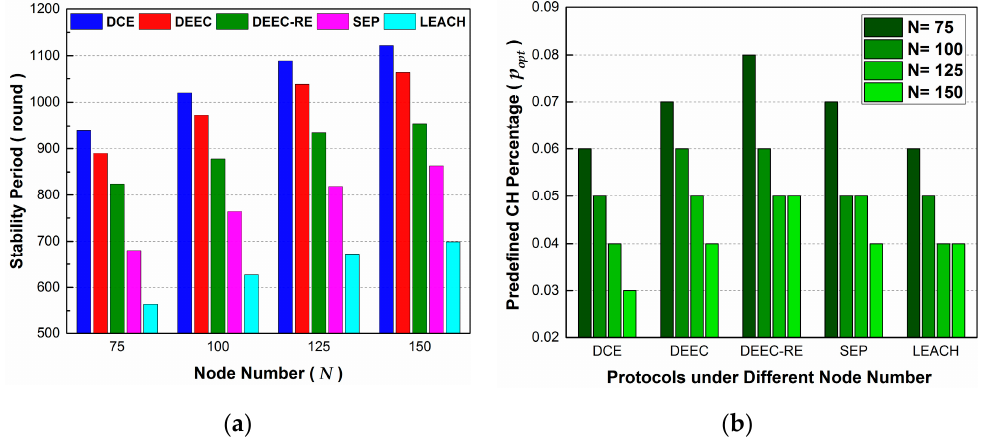
Figure 8. The effect of node number on stability period in Scenario 5: ( a ) The best stability period achieved under different N ; ( b ) The corresponding p opt where the best stability period is